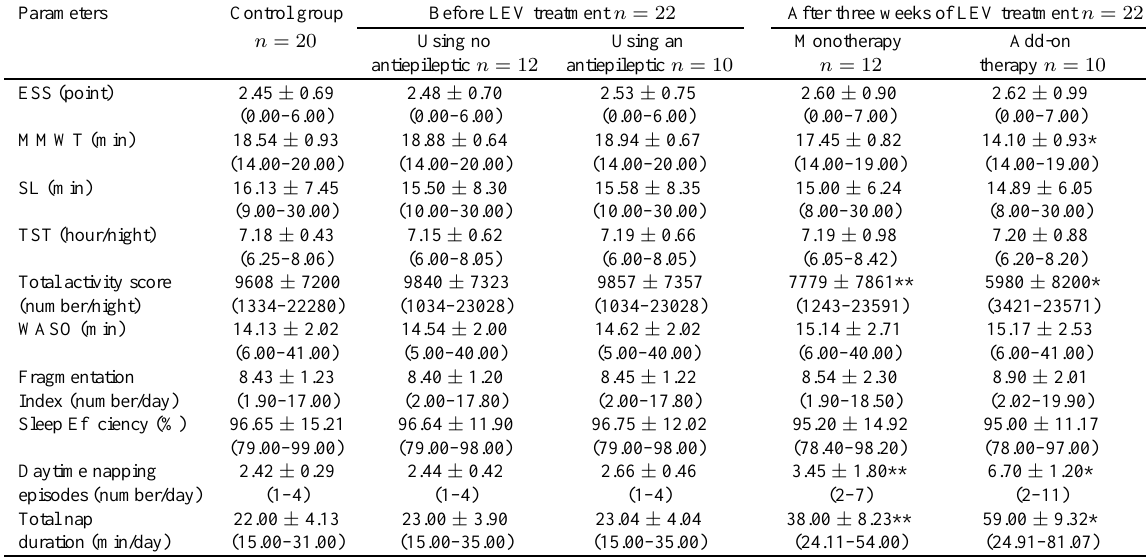
Table 1 Sleep parameters of LEV treated patients and control group